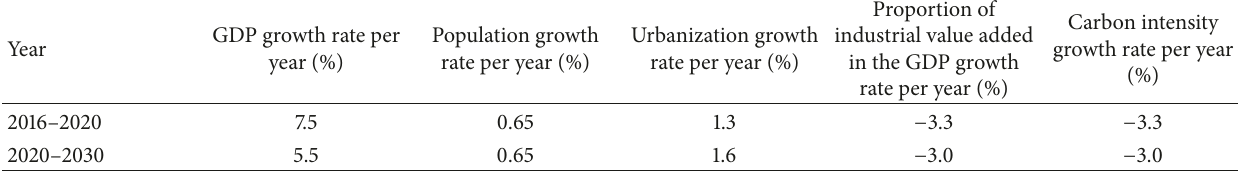
Table 5: Various factors